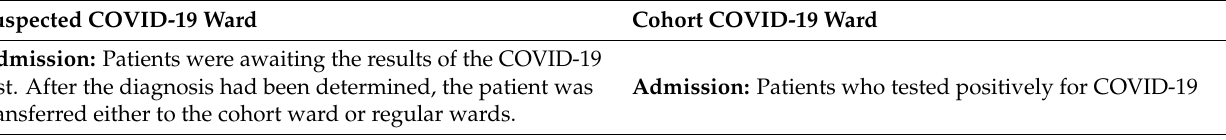
Table 2. Description of the